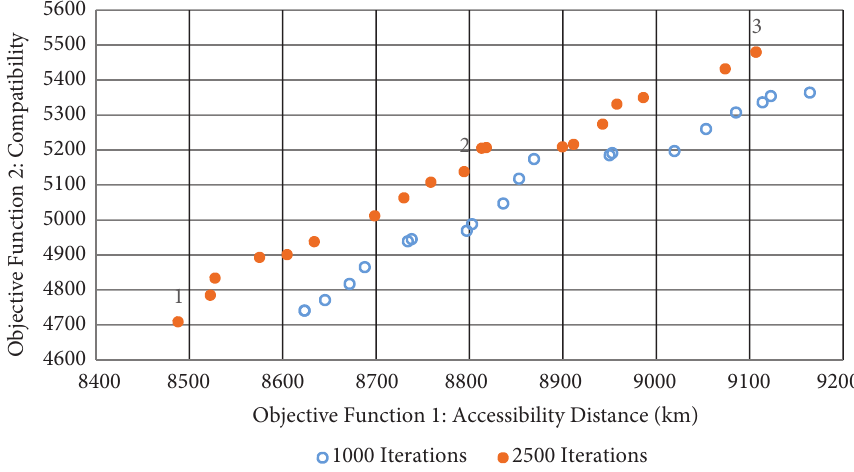
Figure 9. Optimal Pareto front after 1000 and 2500 iterations respectively, based on two objectives of minimum travel distance (km) and compatibility. “1” and “3” are two possible solutions by emphasizing on accessibility and compatibility respectively. “2” is a solution by giving the same weights to the two objective functions